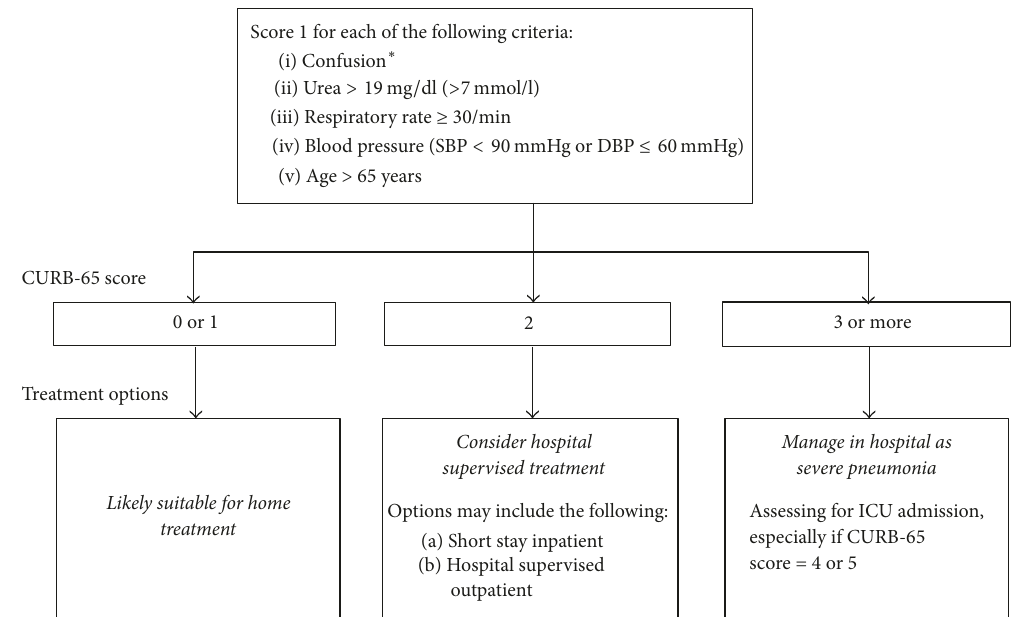
Figure 2: CURB-65 scoring: a simple, fast, and effective clinical decision tool for determining point of care setting in CAP. Urea/blood urea nitrogen (BUN) score can be excluded when unavailable in the urgent care setting. Figure adapted by authors from Lim et al., 2003, with permission [13]. ∗ Defined as a Mental Test Score of 8 or less or new disorientation in person, place, or time.